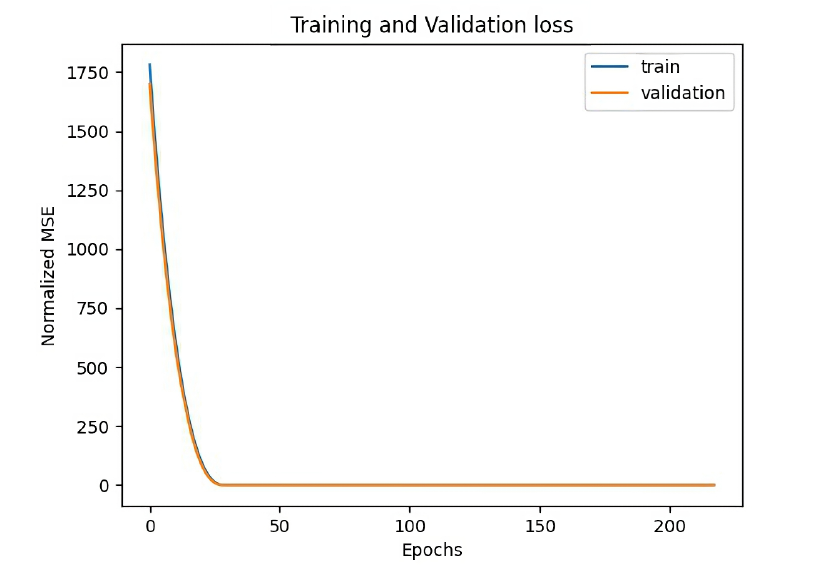
Figure 8. Training and Validation Losses for Sensor